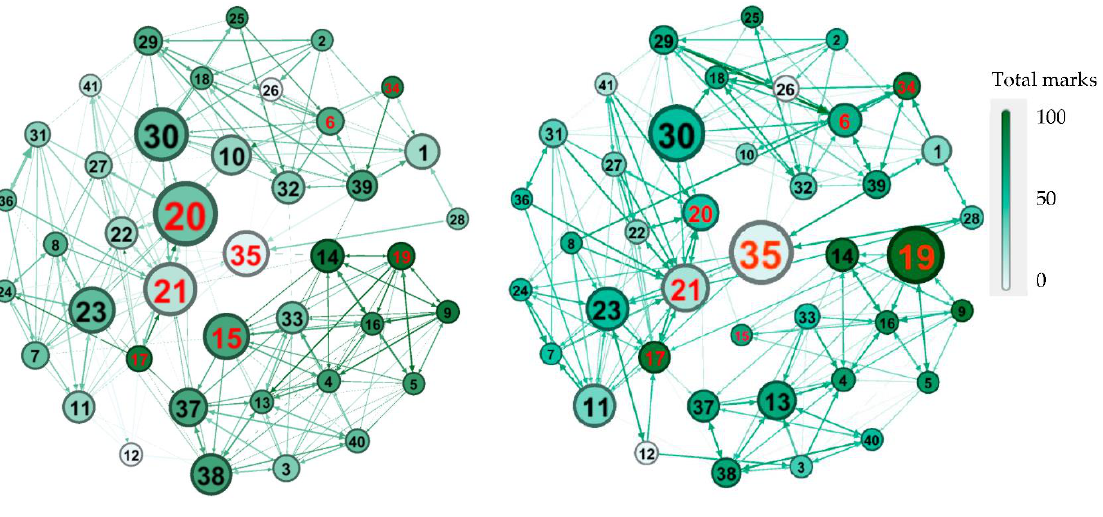
Figure 7. The size of the node represents betweenness centrality and its color represents the final marks. Larger nodes represent a higher value of betweenness centrality and darker colored nodes represent higher marks. Red font is used to highlight the nodes that will be discussed in this section.